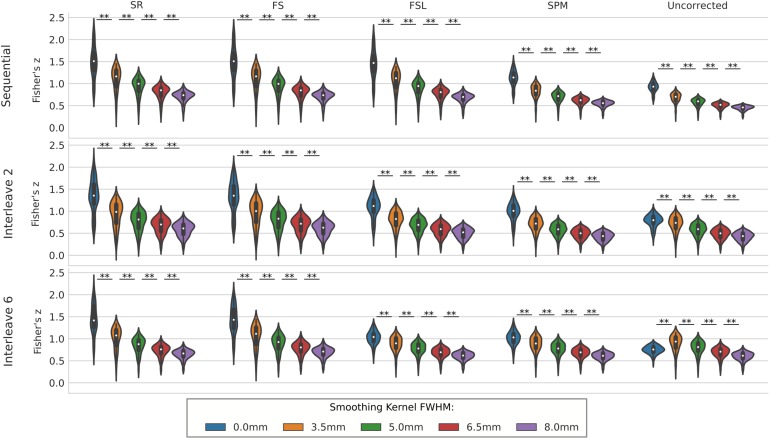
The effect of spatial smoothing on simulated data with STC. Violin plots show the resulting z-scores from the voxels with the top 20 t-statistics for 20 simulated data sets processed with smoothing kernels of 0, 3.5, 5, 6.5, and 8 mm. We examined the effect of smoothing for sequential acquisition, even-odd (interleave 2) and every 6th (interleave 6) acquisition (rows). For each interleave/smoothing condition, statistics were compared across 5 STC conditions: Shifted Regressor, FS, FSL, and SPM STC methods were examined, as well as uncorrected data. For each interleave, the voxels with the top 20 t-statistics were identified from the unsmoothed Shifted Regressor case. The z-score of these 20 voxels are plotted for all other STC methods and all other smoothing conditions. The effect of smoothing is seen as a lowering of the mean z-scores, as well as reducing the variance across STC methods due to the distribution of slice-dependent errors. For interleaved data, the Shifted Regressor method, which is supposed to be a gold standard, performs worse than our proposed FS method due to these distributed errors.